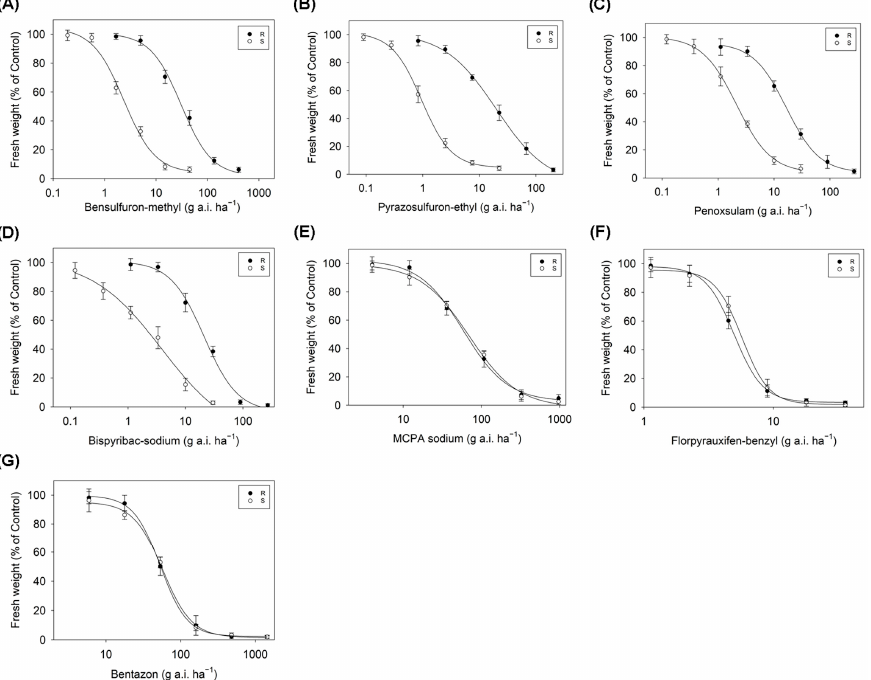
Figure 2. Di ff erent herbicide susceptibilities of the S (HFLJ1, ○ ) and R (BBHY1, ● ) populations of C.